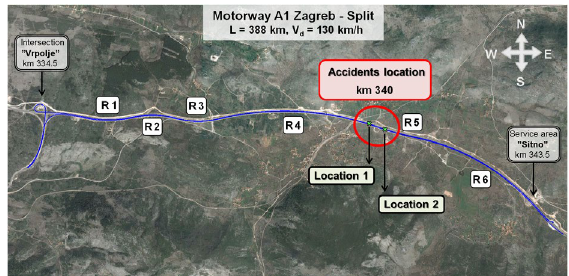
Fig. 1. The accidents location and horizontal alignment of the analysed